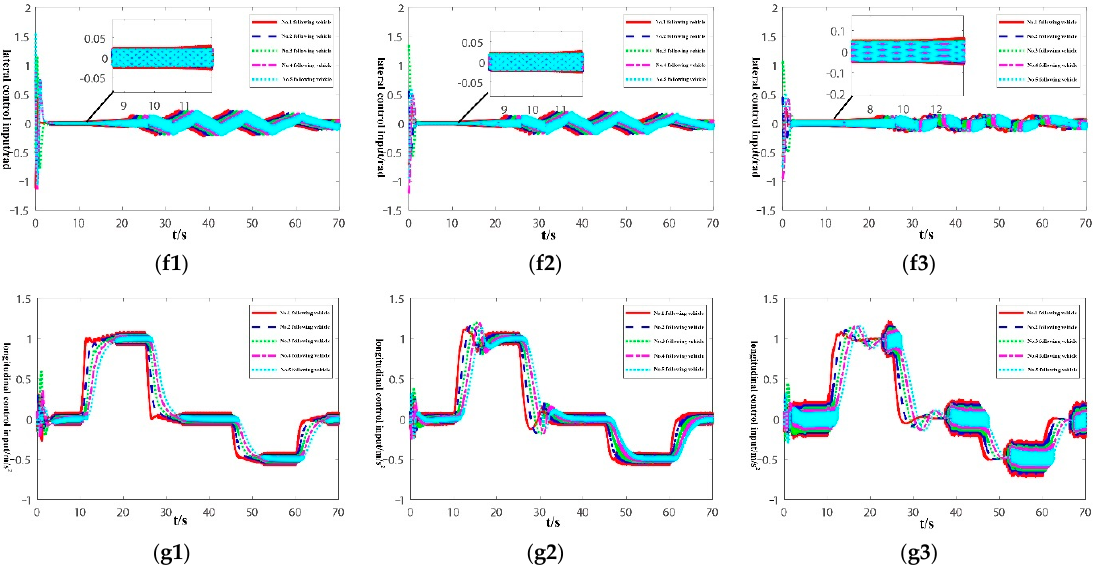
Figure 7. Experimental results of lateral and longitudinal control of bus platoon under different control methods.